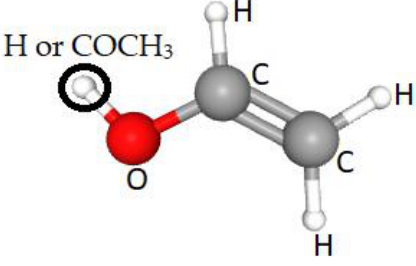
Figure 2. The PVA partially hydrolyzed monomeric structure (where O = H or COCH 3 ).